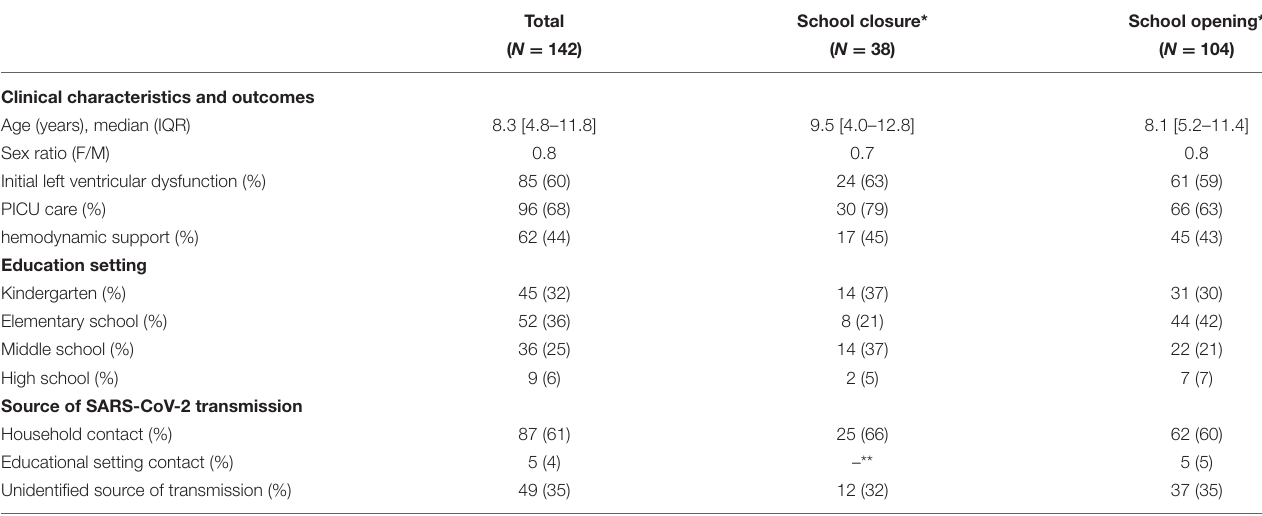
TABLE 1 | Characteristics of children with multisystem inflammatory syndrome ( N =